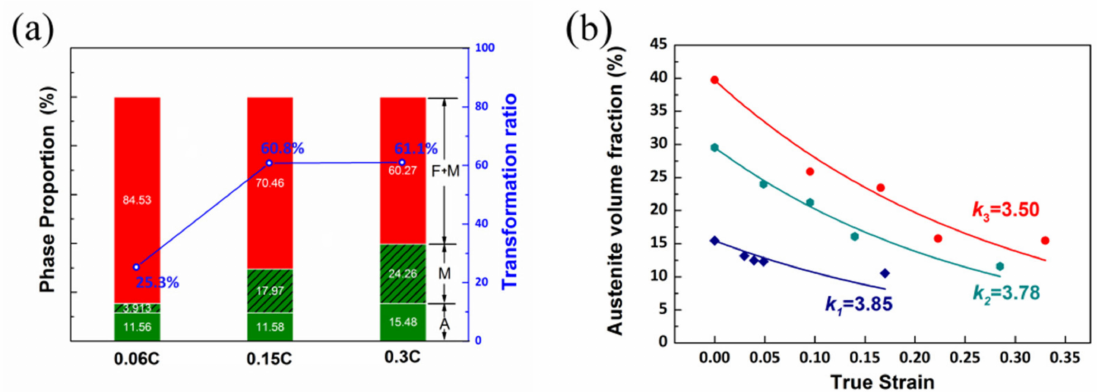
Figure 7. Austenite transformation behavior of the experimental steels. ( a ) Phase proportion and transformation ratio of the experimental steels. ( b ) Austenite stability of different experimental steels.